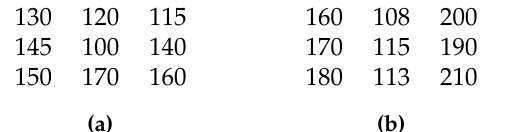
Figure 2. Comparison examples for the bad pixel replacement process ( a ) case of an abnormal pixel ( b ) case of a pixel that belongs to an